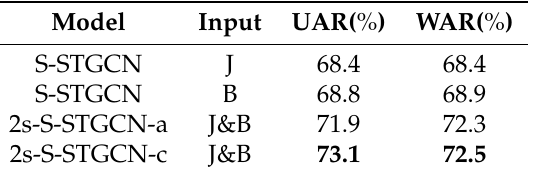
Table 4. Performances of different inputs and fusion strategies. J represents the joint information. B represents the bone information. 2s-S-STGCN-a is the two-stream model using the summation fusion strategy. 2s-S-STGCN-c is the two-stream model using the fully connected